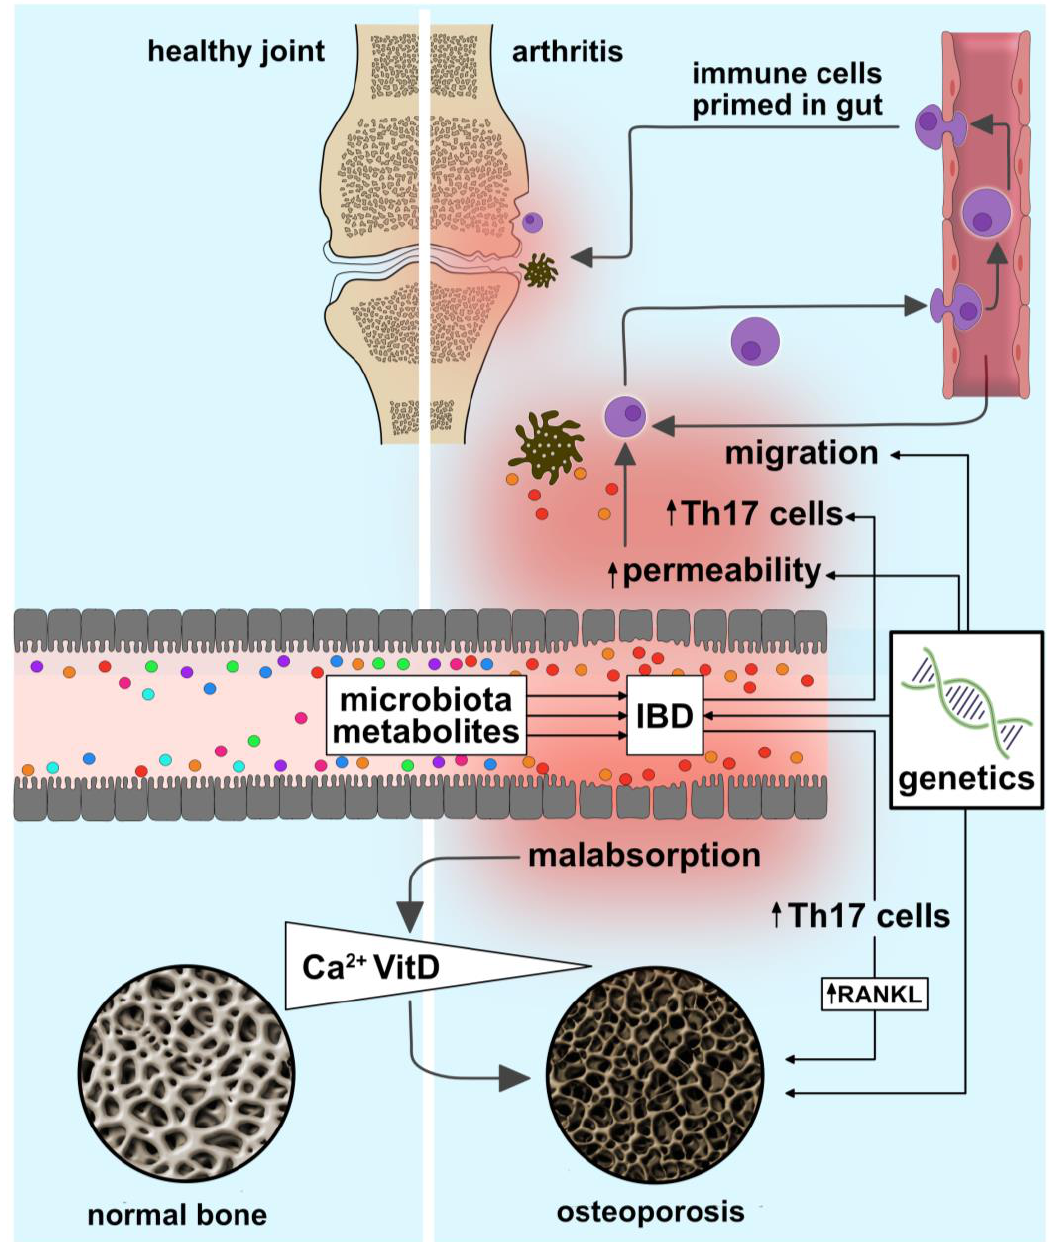
Figure 3. Pathogenic mechanisms underlying bone disease in IBD. IBD is a multifactorial disease driven by environmental factors and complex genetic traits. Gut microbial dysbiosis, intestinal barrier disruption, dysregulated intraluminal metabolism and aberrant immune responses characteristically accompany IBD. For example, dysbiosis-driven immune cell priming mitigates the expansion, the egress and the migration of Th17 cells from the gut into the joints, causing arthritis. Enhanced angiogenesis further promotes inflammatory cell and cytokine transport. Both the inflammation-associated disruption of the intestinal barrier and dysbiotic microbiota can lead to a malabsorption of calcium and disruptions of vitamin D metabolism, underlying the development of osteoporosis.